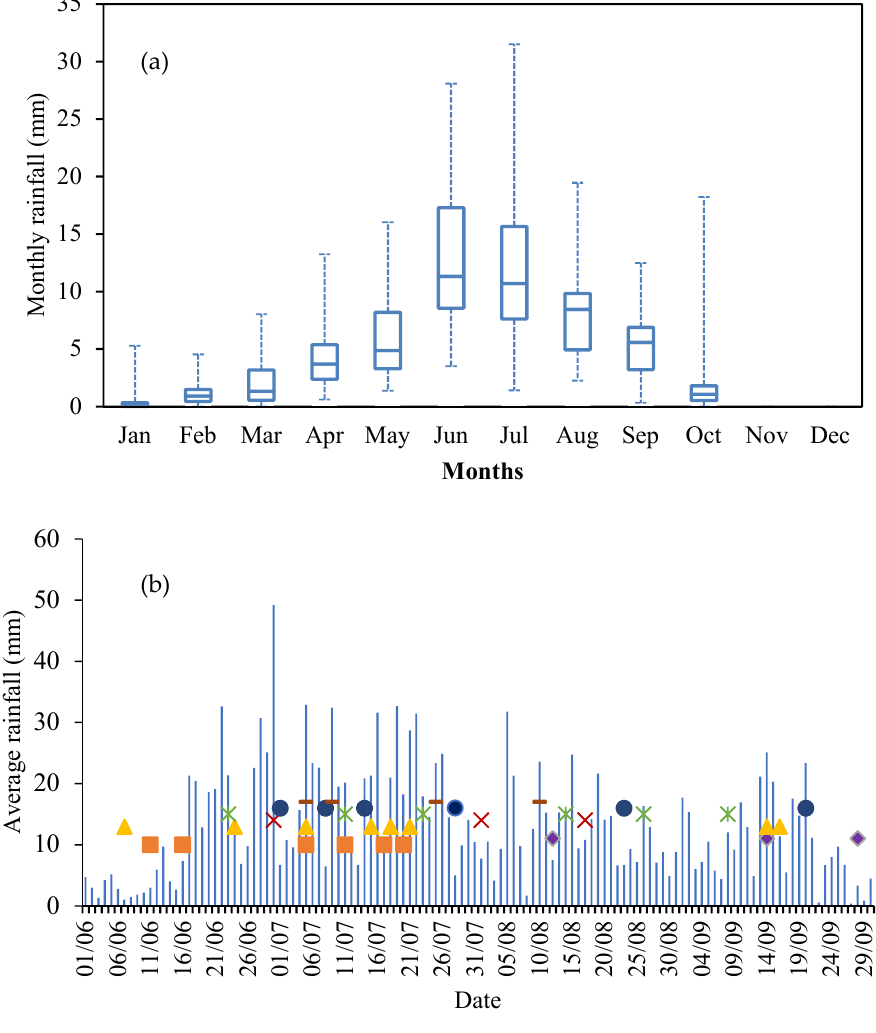
Figure 3. Representation of ( a ) monthly rainfall data in box and whisker plot (2010–2016), ( b ) average daily monsoonal rainfall along with landslide events considered for analysis.